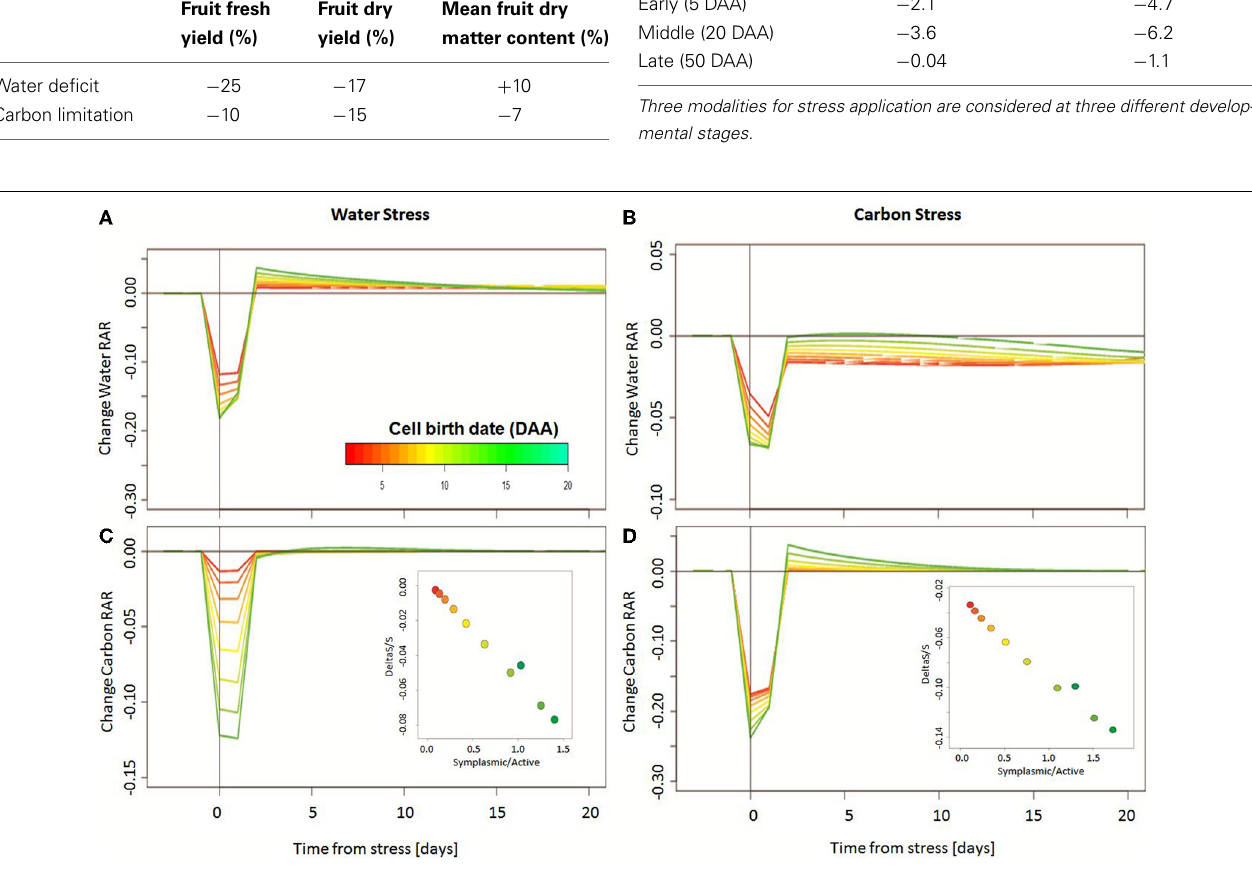
stress, relative dry mass loss is directly linked to the symplasmic over active transport ratio of the cell, at the time of stress. Young cells with a high symplasmic transport appear more sensitive to stress than old ones, with a reduction in dry mass over 5% for water deficit, and over 10% for carbon